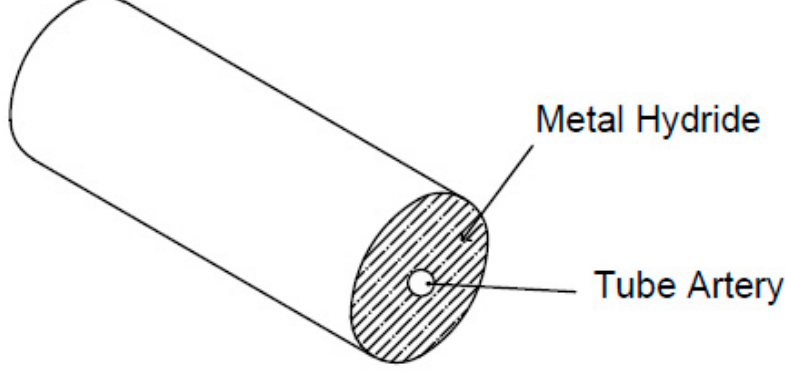
Figure 2. A typical tubular